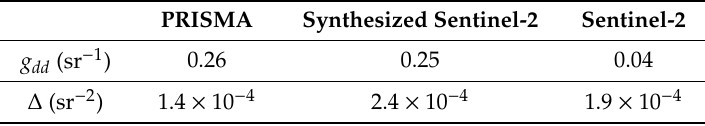
Table 5. Average g dd and ∆ derived through the